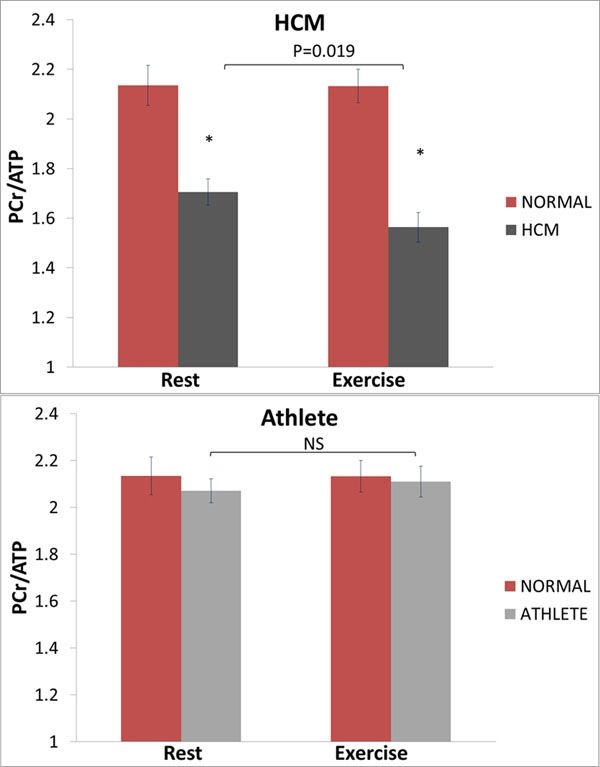
The effect of exercise on PCr/ATP in normal controls, HCM, and Athletes, showing a reduction in the HCM group, but no change in athletes or normal.*p<0.05 vs normal.